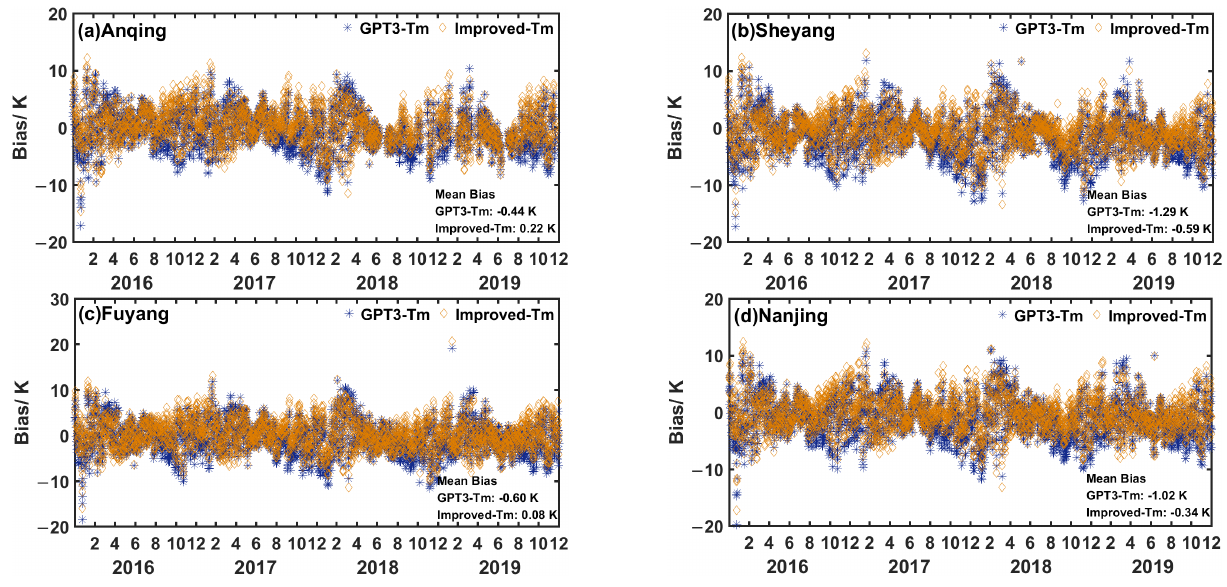
Figure 7. The bias of GPT3- T m and improved- T m in Anqing ( a ), Sheyang ( b ), Fuyang ( c ) and Nanjing ( d ) during the 2016–2019 period. Table 4 is the precision statistics of the improved- T m and the GPT3- T m from 2016 to 2019. It can be seen that the mean Bias and RMS of improved- T m are − 0.6 K and 2.7 K in 2019, respectively, which are improved by 0.8 K and 0.4 K, respectively, compared to that of GPT3- T m . Although the improvement of RMS is small, the bias of each station decreases steadily. Therefore, the improved T m model in the paper has a higher and more stable precision than the GPT3 model in the Yangtze River Delta region. Table 4. Precision of the GPT3- T m and the improved- T m in the Yangtze River Delta during the 2016–2019 period (K). GPT 3 - T m Sites Bias RMS Bias RMS Bias